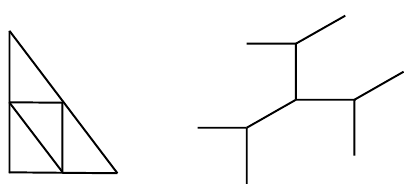
Figure 1 . The toric diagram (on the left) and its dual 5-brane web diagram (on the right) for the T 2 geometry, the supersymmetric C 2 = Z 2 (cid:2) Z 2